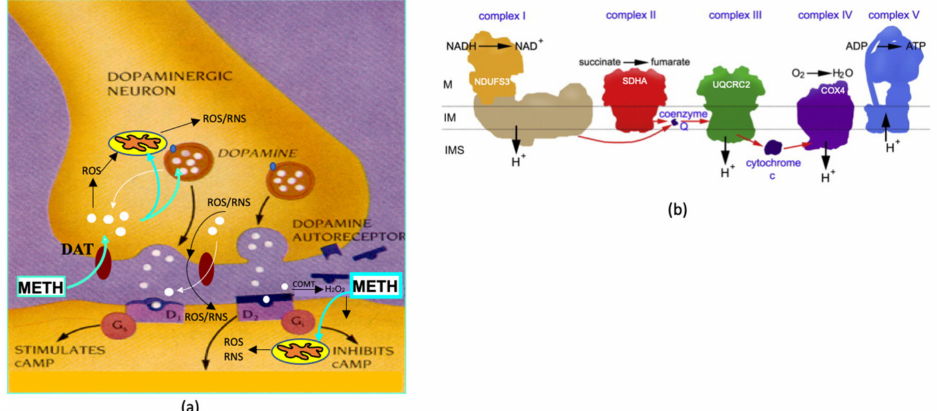
Figure 1. ( a ) Methamphetamine (METH) effects in the striatum. METH is taken up by dopamine (DA) transporter (DAT) and triggers the release of DA from the storage vesicles to the cytoplasm within DAergic terminals and subsequently to the synaptic cleft. Released DA quickly autoxidizes, producing several reactive oxygen species (ROS). ROS-damaged mitochondria produce more ROS and reactive oxygen species (RNS). Some DA-derived ROS and RNS diffuse to postsynaptic neurons and glia and affect mitochondria therein. ( b ) Electron transport chain (ETC) complexes (adapted from [28]) with localization of NDUFS3, SDHA, UQCR2, and COXIV subunits. Abbreviations: COMT, catechol-O-methyltransferase (catalyzes DA metabolism to hydrogen peroxide (H 2 O 2 )); IM, inner membrane; IMS, intramembrane space; M,